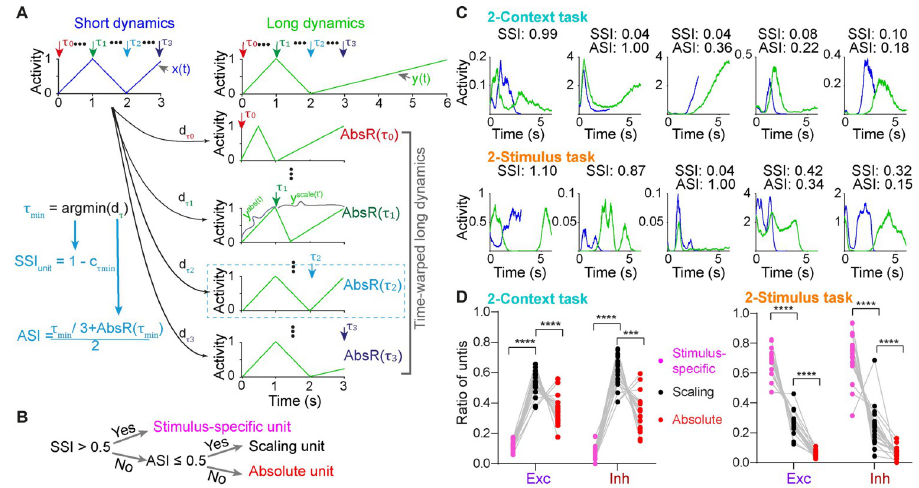
Fig 5. Different distribution of stimulus-specific, scaling, and absolute units between the 2-Context and 2-Stimulus tasks. ( A ) Schematic of the definitions of the stimulus-specific index (SSI unit ) and absolute vs. scaling index (ASI) at the single unit level. Consider a hypothetical firing rate profile of a unit during a short (blue, x(t)) and long (green, y(t)) trial. As described in Methods, a series of time-warped long dynamics are generated at breaking point τ x : before τ x the dynamics are the same during both the short and long intervals (absolute timing, y abs (t)); after τ x the dynamics is the scaled version of the corresponding original long dynamics ( > τ x , scaling timing, y scale (t’)). Pairwise Euclidean distance between short dynamics and all time-warped long dynamics are computed at each τ x . The point at which the distance is minimal defines τ min and is used to compute the SSI unit as in SSI pop . To compute the ASI, a normalized measure of the distance before and after τ min is calculated (AbsR) as described in Methods to quantify the weighting factor for the absolute part (before τ min ) and the scaling part (after τ min ). ASI is defined by τ min and the weighting factor based on AbsR( τ min ). ( B ) For a given unit, the SSI unit is computed first, and if the SSI unit is higher than 0.5, it is classified as stimulus-specific unit. If the SSI unit is lower than 0.5, its ASI is computed, and it is classified as scaling unit if its ASI is lower than 0.5, otherwise as an absolute unit. ( C ) Dynamics of five example unit traces for short (blue) and long (green) intervals for the 2-Context (top) and 2-Stimulus (bottom) tasks, the corresponding SSI and ASI values are shown on top. Notice that for a given unit, ASI is only computed only when its SSI unit is lower than 0.5. ( D ) For the 2-Context task (left), most units are classified as scaling units—for both excitatory and inhibitory units (n = 20 simulations, two-way ANOVA with repeated measures, for the unit classification factor: F (2 , 38) = 114.4 and P < 0.0001, posthoc Tukey tests P < 0.0001). For the 2-Stimulus task (right), stimulus-specific units are the most common ( n = 20 simulations, two-way ANOVA with repeated measures, F = 181.5 and P < 0.0001, posthoc (2 , 38) Tukey tests P <